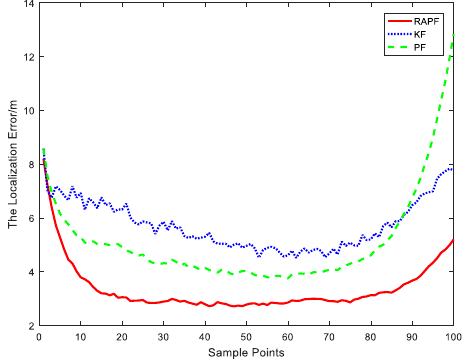
Figure 5. The localization error at each sample points.